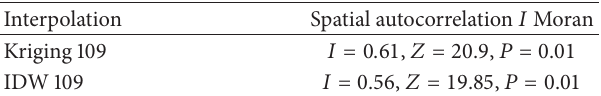
Table 4: Spatial